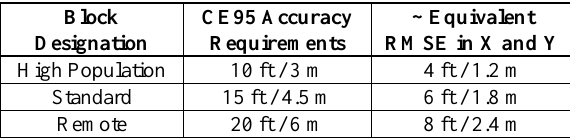
Table 1: Minimum absolute positional accuracy requirements by class of block. In practice, to date all “Remote” blocks have meet or exceeded the “Standard” accuracy requirement.